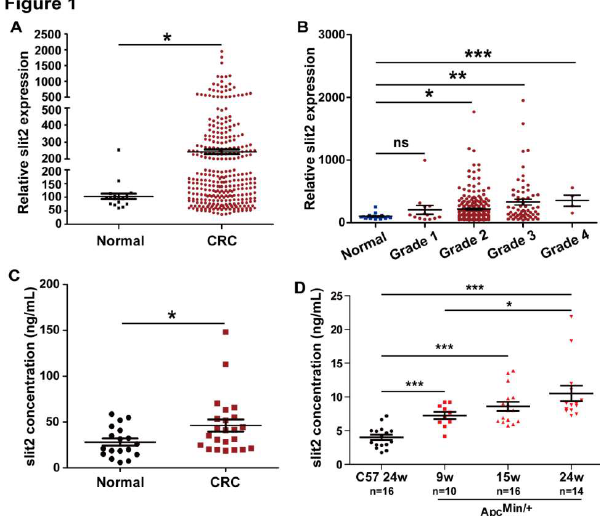
Figure 1. The expression of Slit2 in patients with CRC and Apc Min/+ mice. ( A ) Relative gene expression levels of Slit2 in the normal and primary tumor tissues of CRC cases from the MERAV database was analyzed. Relative Slit2 expression was significantly increased in the primary tumor tissues of CRC patients ( n = 321) compared with normal samples ( n = 19). ( B ) Relative gene expression levels of Slit2 in normal tissues and different grades of primary tumor tissues of CRC cases from the MERAV database. Relative Slit2 expression is gradually unregulated with the increase of the pathological grade of primary CRC patients. There is no statistical difference in the Slit2 expression, as shown by the t - test between the normal group ( n = 19) and grade 1 primary CRC patients ( n = 13). A significant increase of Slit2 expression can be seen between the normal group and grade 2 ( n = 241), grade 3 ( n = 63), and grade 4 ( n = 4) primary CRC patients. ( C ) The protein concentration of Slit2 in the serum of healthy volunteers and CRC patients was detected by the ELISA assay. Increasing expression of Slit2 in the serum of CRC patients ( n = 23) can be seen compared with that in normal healthy volunteers ( n = 18). ( D ) The protein concentration of Slit2 in wild type (C57) mice or Apc Min/+ mice with different pathologic stages was detected by the ELISA assay. Slit2 increases in the serum of Apc Min/+ mice compared with in wild type mice. Additionally, Slit2 gradually increases during tumor development. *: p < 0.05, **: p < 0.01, and ***: p < 0.001.